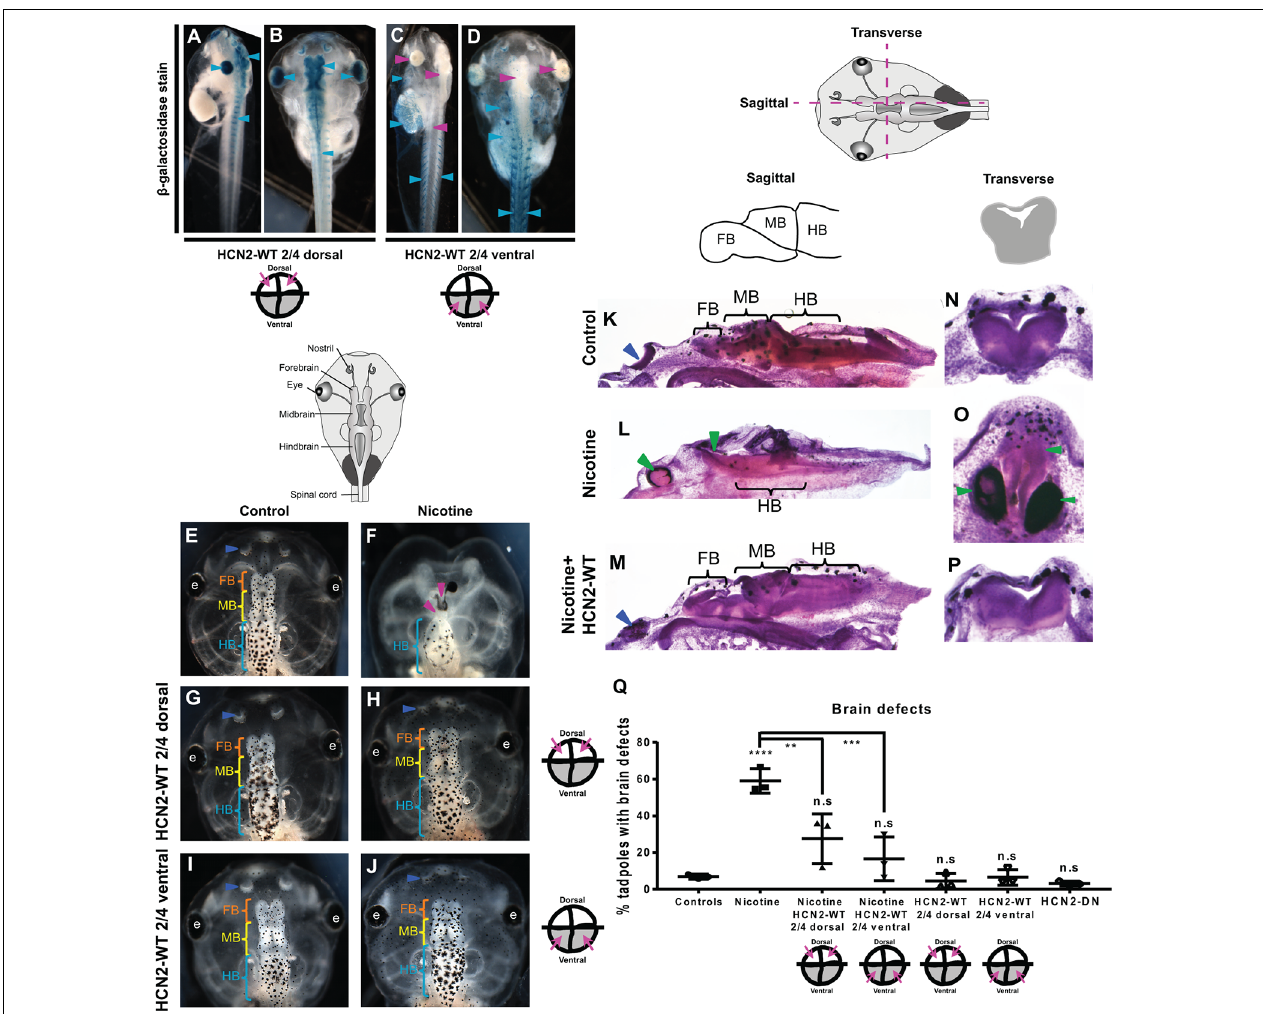
FIGURE 1 | Both local (CNS) and distant (non-CNS) expression of HCN2 channels rescues nicotine-induced brain morphology defects in Xenopus embryos. (A–J) Representative images of stage 45 tadpoles. (A–D) β -galactosidase expression assessed using X-Gal (blue) in bleached tadpole co-injected with Hcn2-WT and β -galactosidase mRNA. β -galactosidase was observed mainly in the eye, brain, and spinal cord (cyan arrowheads), of dorsal blastomere injections. In ventral blastomere injections, β -galactosidase was absent from the eye, brain, and spinal cord (magenta arrowheads) and was mainly present in the brachial arches, gut, heart, and muscles (cyan arrowheads). (E–J) Control (untreated and uninjected) or nicotine-treated tadpoles with or without microinjection with Hcn2-WT mRNA either in dorsal or ventral blastomeres at the four-cell stage. Blue arrowheads indicate intact nostrils, orange brackets indicate intact forebrain (FB), yellow brackets indicate intact midbrain (MB), cyan brackets indicate intact hindbrain (HB), intact eyes (e), and magenta arrowheads indicate severe brain morphology defects. (K–P) Histological staining (hematoxylin and eosin) of agarose sections through the brain (sagittal and transverse sections through midbrain) of stage 45 tadpoles. Control (untreated and uninjected) or nicotine-treated tadpoles with or without microinjection with Hcn2-WT mRNA in the ventral blastomeres at the four-cell stage. FB-forebrain, MB-midbrain, HB-hindbrain, blue arrowheads indicate intact nostrils, and green arrowheads indicate severe brain morphology defects. (Q) Quantification of stage 45 tadpole brain morphology defects under indicated conditions. Percentage of tadpoles with brain defects for each experimental group are Controls—7%, Nicotine—59%, Nicotine+HCN2-WT 2/4 dorsal—27%, Nicotine+HCN2 2/4 ventral—16%, HCN2 2/4 dorsal—5%, HCN2 2/4 ventral—6%, and